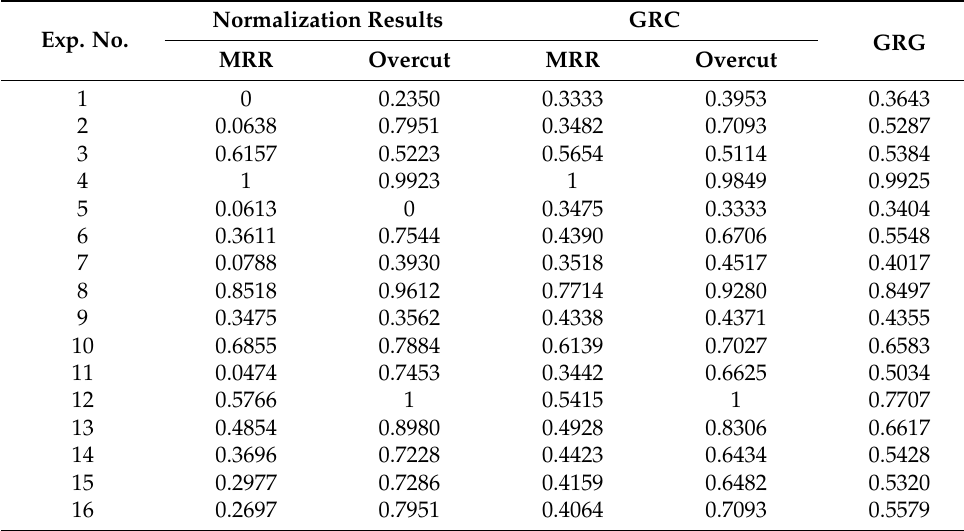
Table 8. Normalized data, GRC and GRG values. Grey relational coefficient (GRC). Grey relational grade